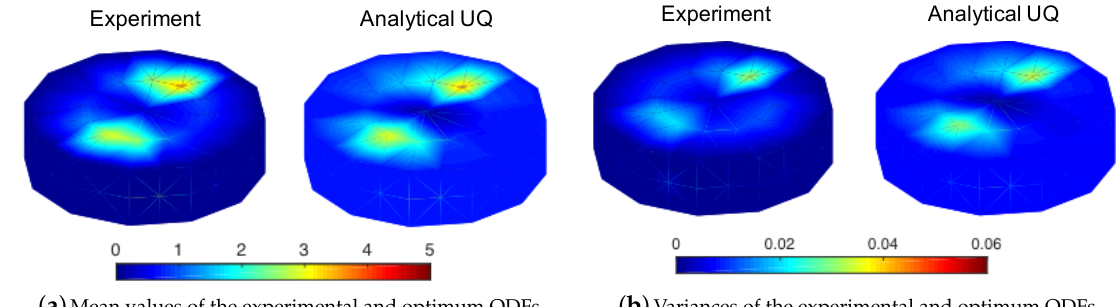
Figure 4. Optimum solution for the uncertainty in microstructural texture. UQ: uncertainty